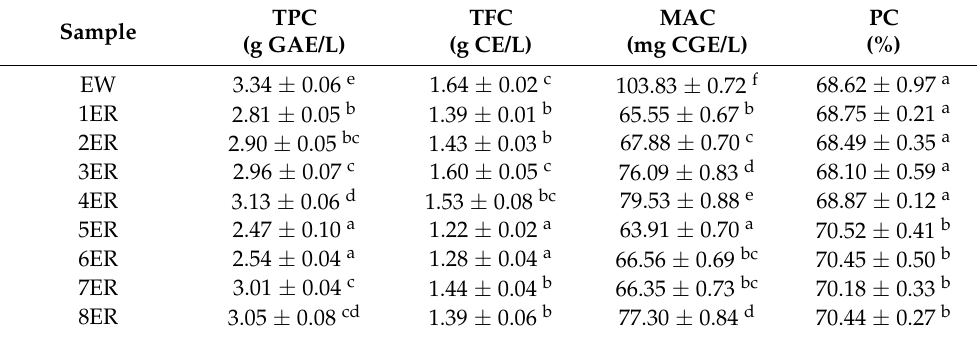
Table 4. Phenolic compounds content of initial ecological Cabernet Sauvignon red wine and retentates obtained by reverse osmosis at 2.5, 3.5, 4.5, and 5.5 MPa with cooling and without cooling. TPC Sample (g